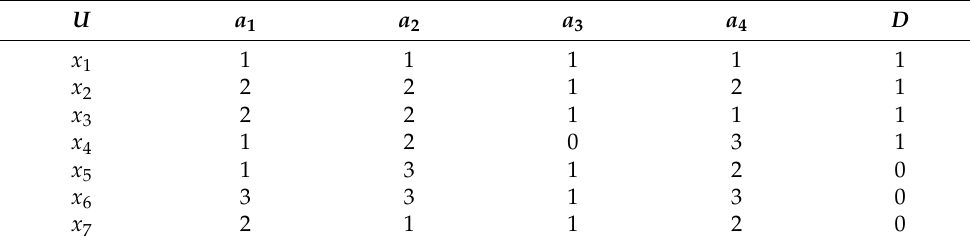
Table 1. Weather observation